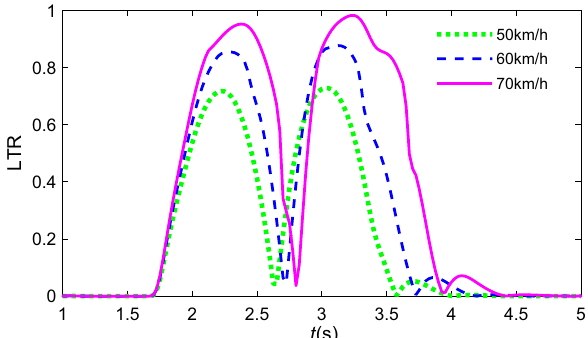
Figure 16. Transient response of LTR at different initial speeds.